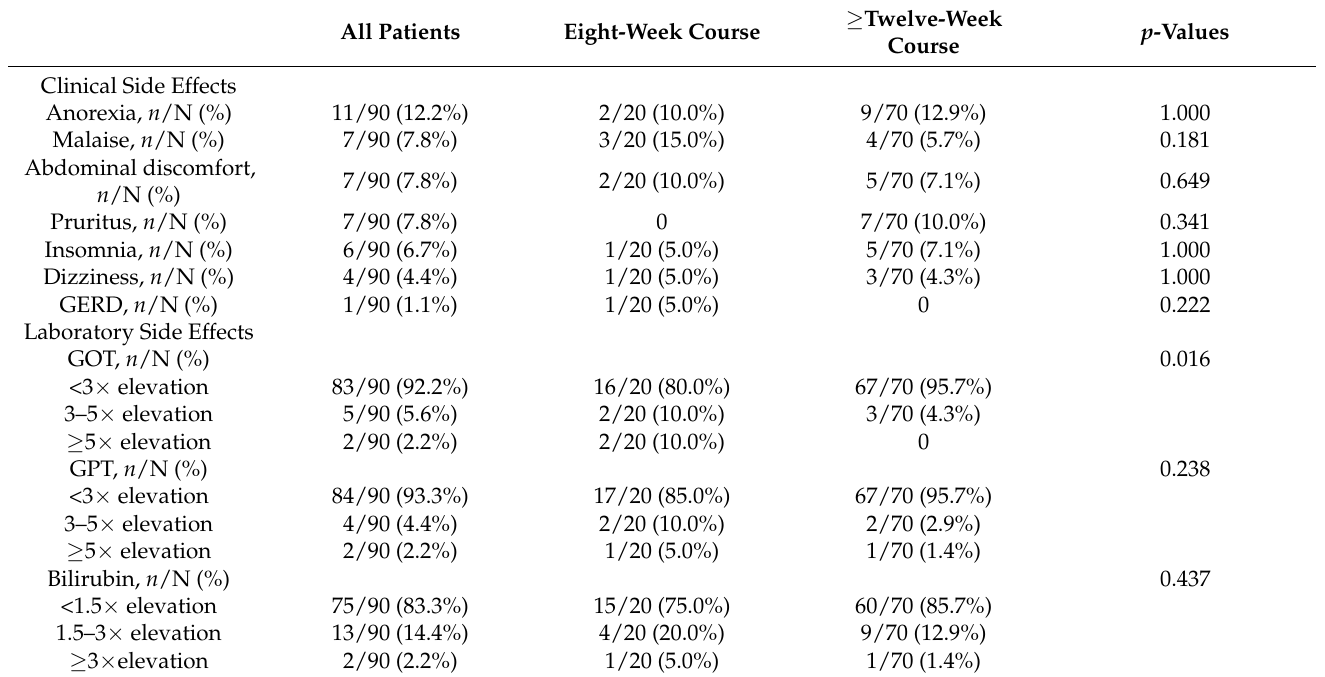
Table 3. Treatment side